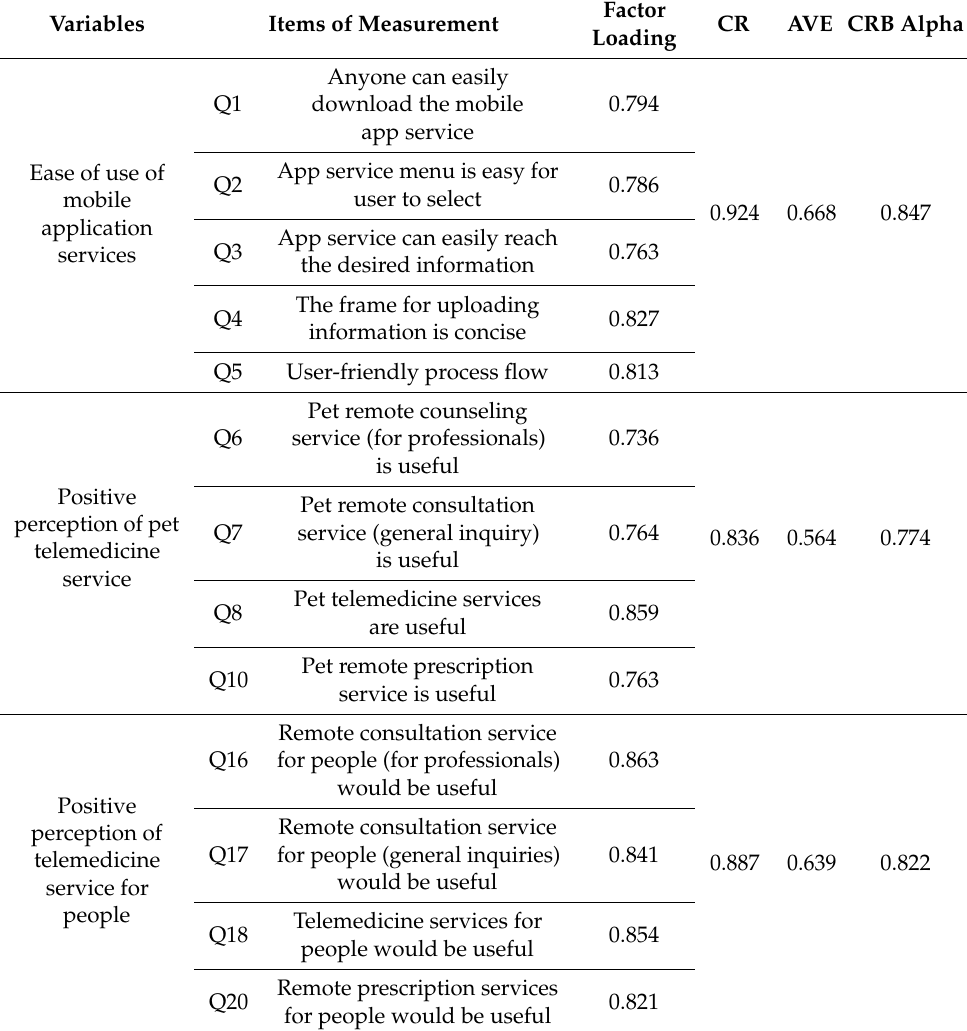
Table 5. Reliability and convergent